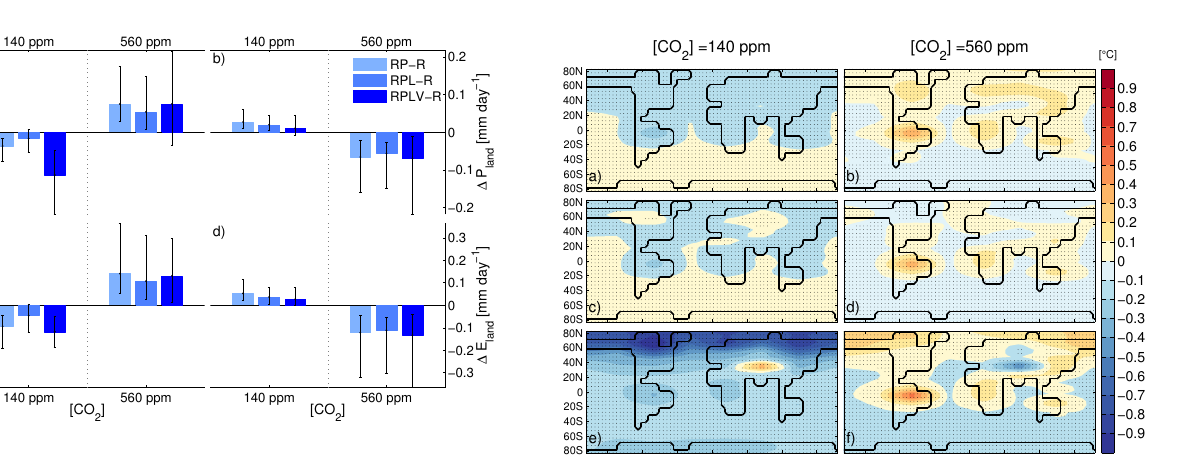
Fig. 5. Global annual land anomalies of (a) surface air temperature, (b) precipitation, (c) net short-wave radiation at the surface and (d) evapotranspiration for RP, RPL and RPLV experiments. All anoma- lies are relative to the R experiment which considers only the radia- tive effect of CO 2 . Shown are the median and the 5–95 percentile range of the ensemble.